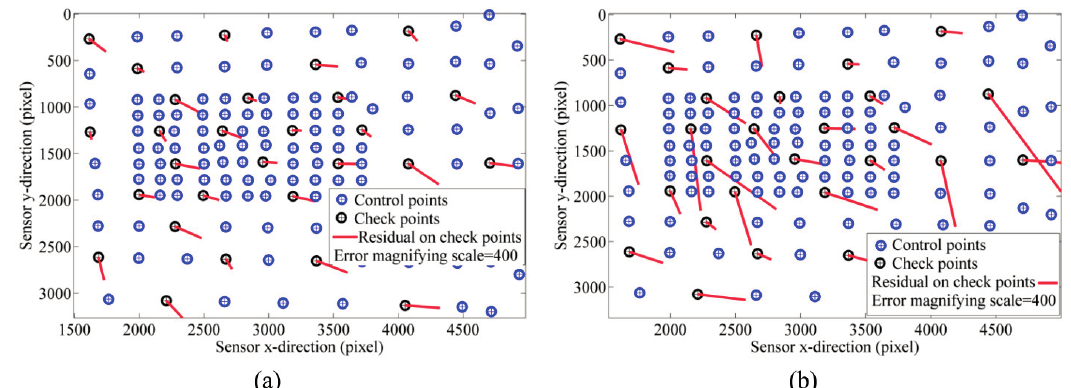
Figure 16. Calibration results ( a ) Residuals on checkpoints based on automatic target detection; ( b ) Residuals on checkpoints based on manual target